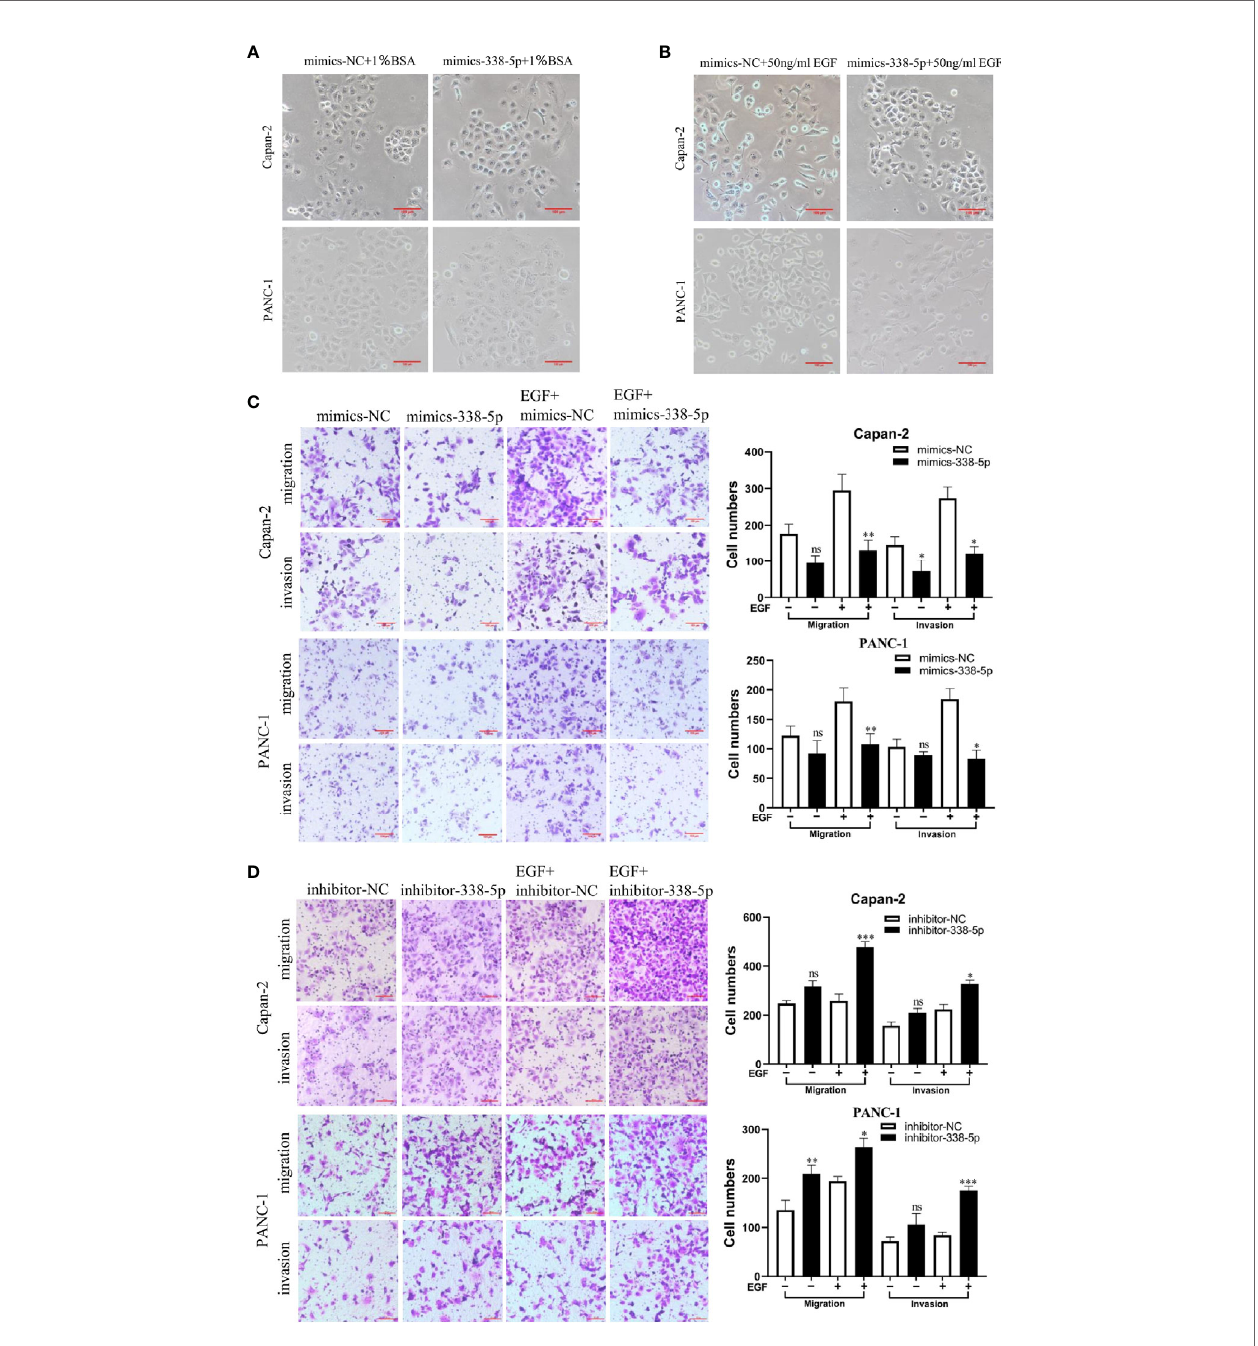
FIGURE 3 | miR-338-5p promotes pancreatic cancer cells EMT, migration and invasion in vitro . (A) without EGF treatment, the Cell morphology of Capan-2 and PANC-1 cells in mimics NC, and miR-338-5p mimics groups. (B) Upon EGF treatment (50 ng/ml), fi broblastoid-like phenotype of Capan-2 and PANC-1 cells in mimics NC, and miR-338-5p mimics groups. (C) With or without EGF treatment, Capan-2 cells, and PANC-1 cells transfected with mimics NC, miR-338-5p mimics, detected by transwell migration and invasion assay. Scale bar, 100 m m. (D) Migration and invasion of Capan-2, and PANC-1 cells transfected with inhibitor NC, or miR-338-5p inhibitor. Scale bar, 100 m m. All data are shown as the mean ± SEM. *P < 0.05; **P < 0.01; ***P < 0.001; ns, no signi fi